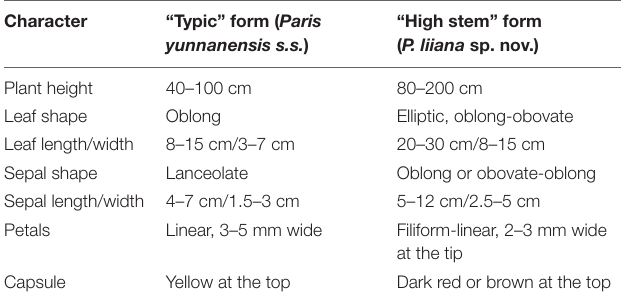
TABLE 2 | Morphological character differences between Paris yunnanensis s.s. and P. liiana sp. nov. Character “Typic” form ( Paris yunnanensis s.s. )